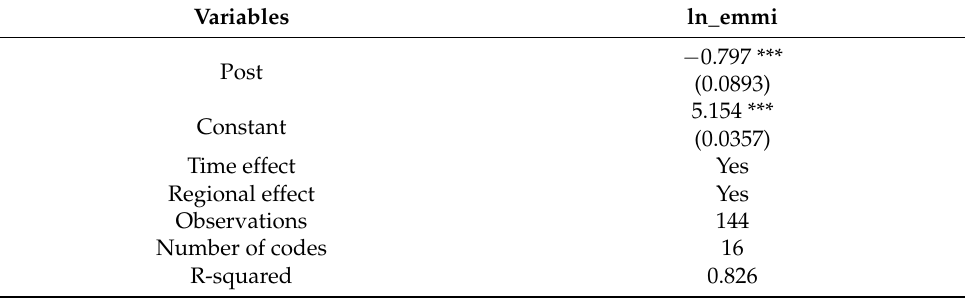
Table 4. Statistical table of regression results (2) 1